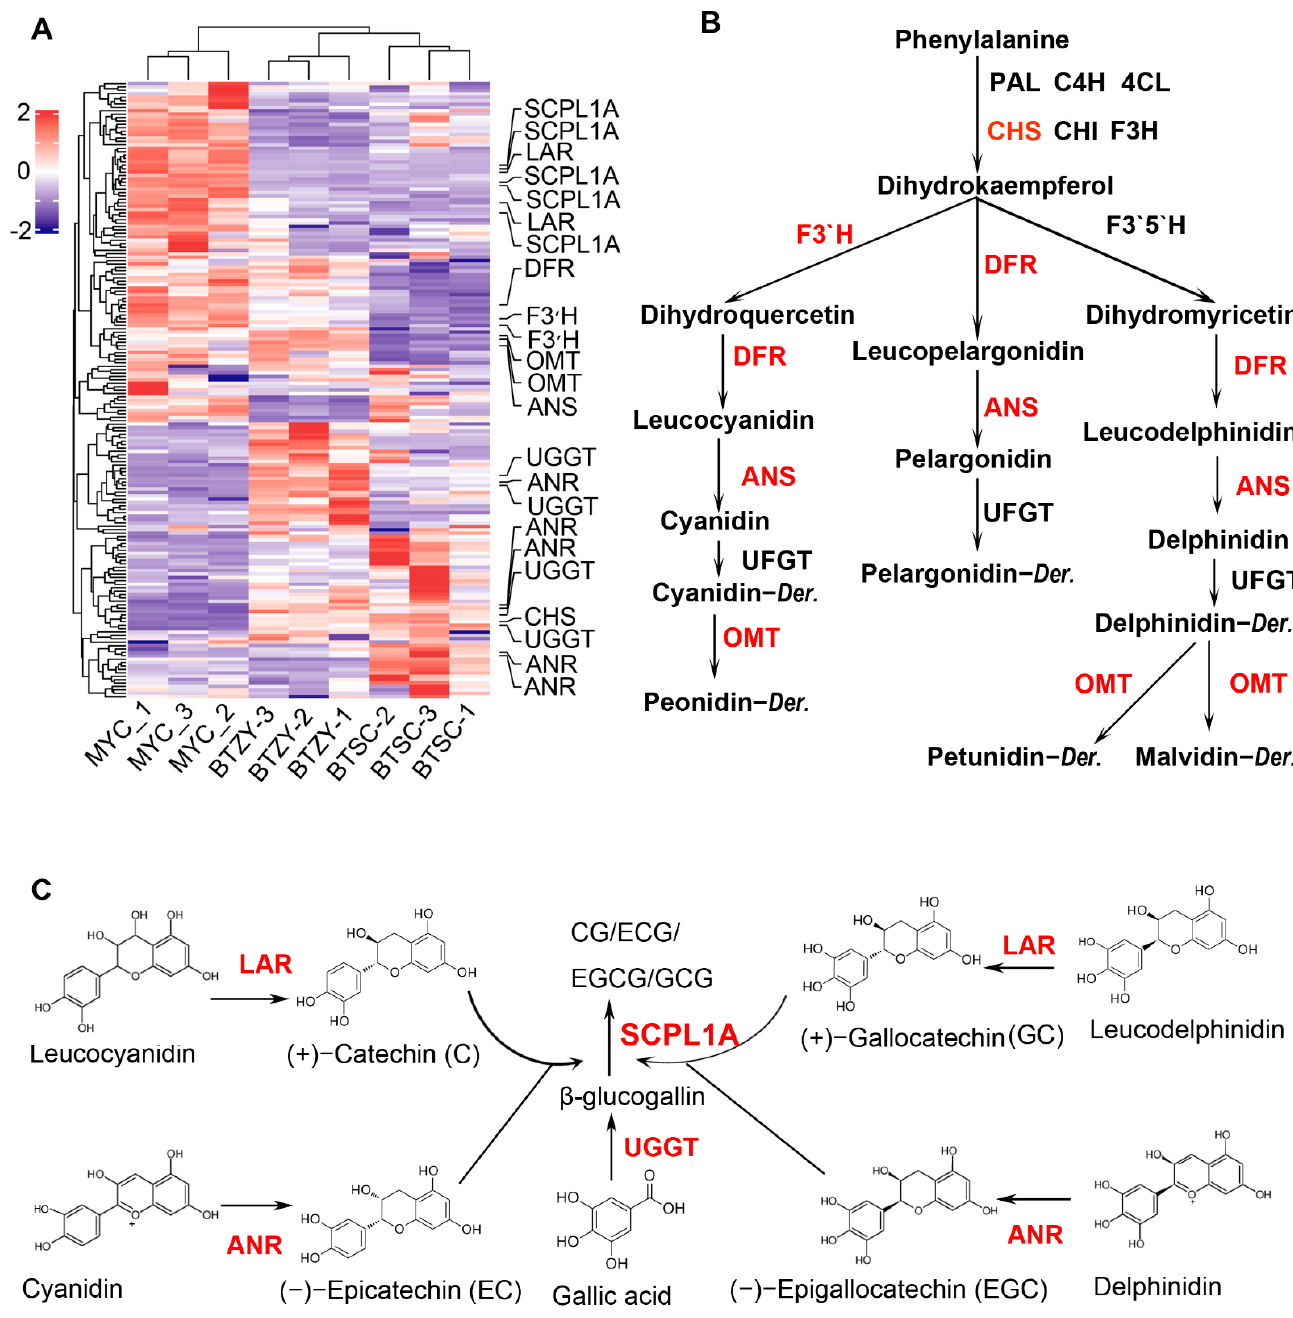
Figure 5. Identification of DEGs involved in anthocyanin and catechin biosynthesis. ( A ) the heat map of DEGs involved in anthocyanin and catechin biosynthesis; ( B ) the DEGs in anthocyanin biosynthesis pathway; ( C ) the DEGs in catechin biosynthesis pathway. The DEGs were noted by red font in ( B , C